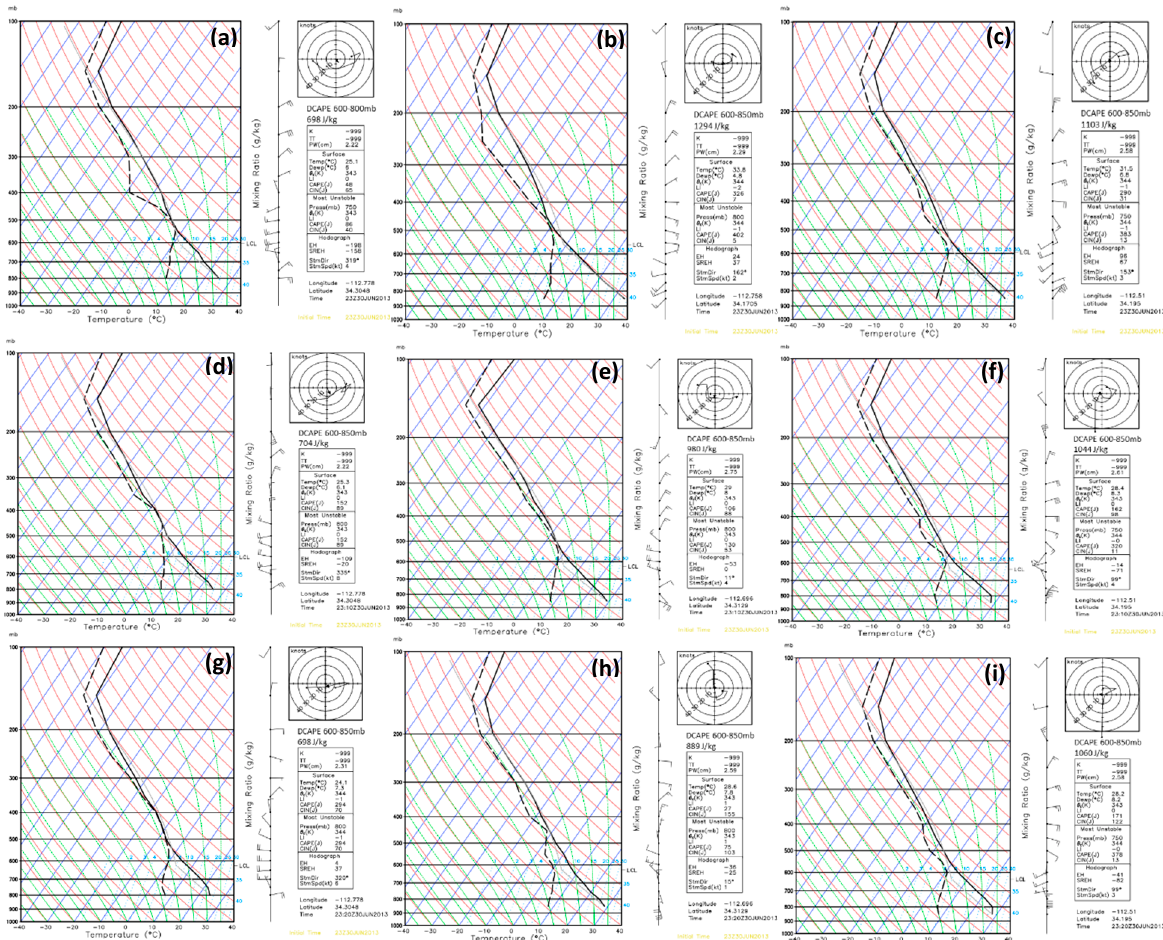
Figure 9. WRF-LES 259 m simulated soundings at locations 1 ( a , d , g ), 2 ( b , e , h ), and 12 ( c , f , i ) in Figure 3b and valid at ( a – c ) 2300 UTC, ( d – f ) 2310 UTC, and ( f – h ) 2320 UTC 30 June 2013, respectively.